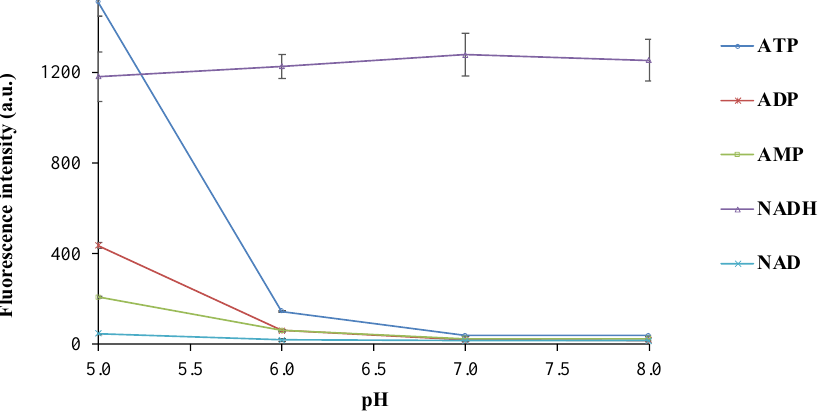
Figure 8. Effect of pH on fluorescence intensities of different fluorophore solutions at highest peak condition.